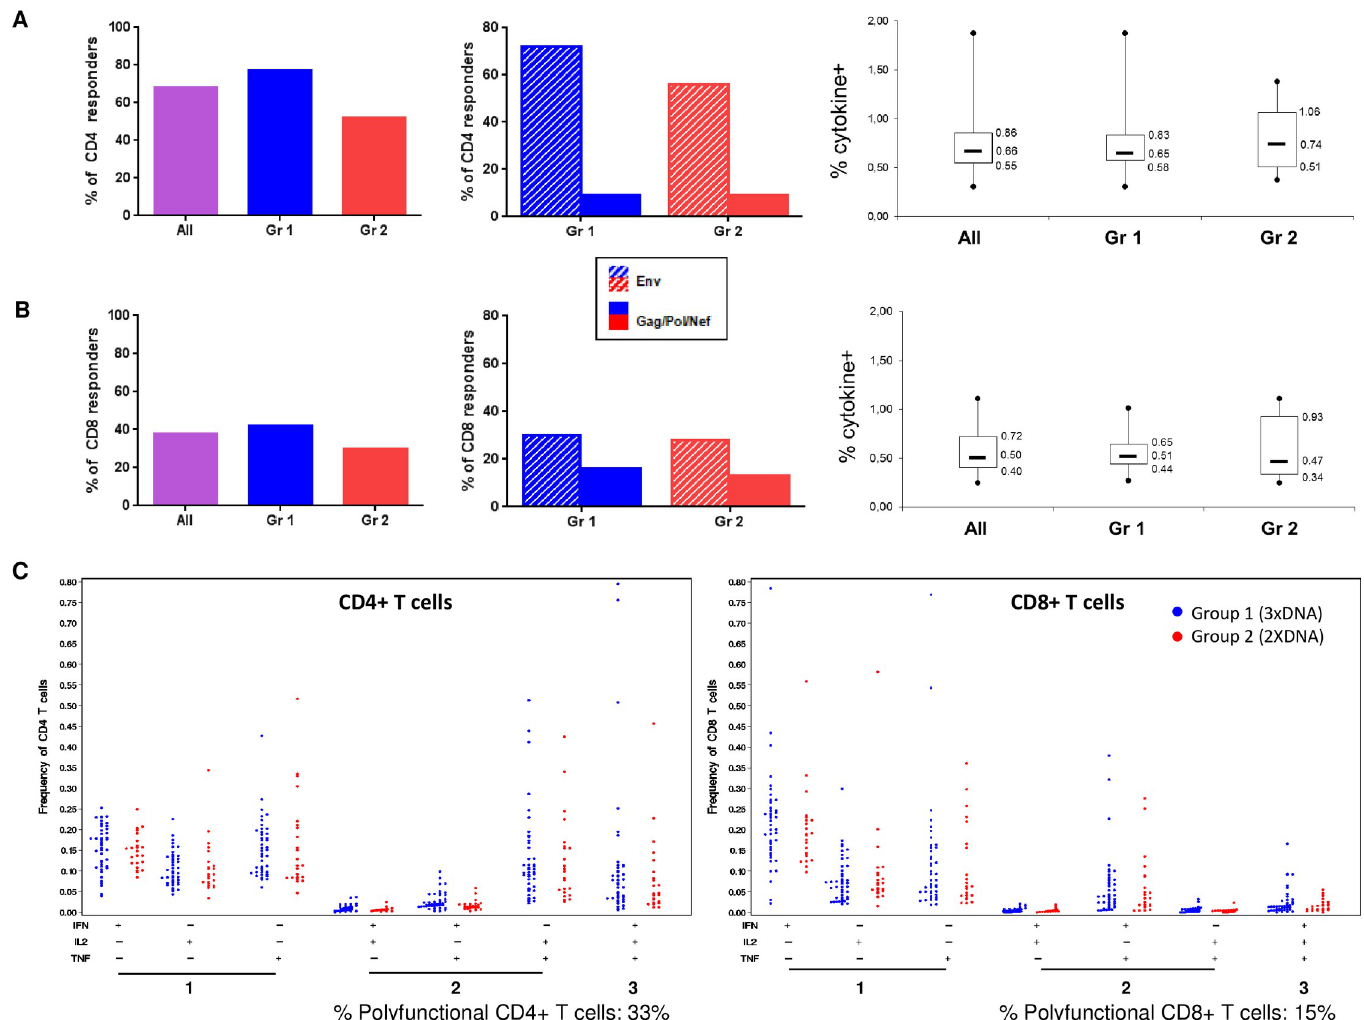
Fig 4. Frequency and magnitude of CD4 + and CD8 + T-cell responses in vaccine groups at the primary end points (weeks 26/28) measured by ICS assay, EV03/ANRS VAC20 Phase I/II Trial. A. Left panel: Frequency of positive response for CD4+ T cells producing at least one cytokine (IFN- γ , TNF- α or IL2) to at least one HIV pool in all participants (n = 72) or in each group (n = 43 in 3xDNA group, blue; n = 23 in 2xDNA group, red). Middle panel: Frequency of positive response for CD4+ T cells producing at least one cytokine to Env (hatched histograms) and Gag/Pol/Nef (solid histograms) in each group. Right panel: Magnitude of CD4+ T cell response in all participants and in each group. Boxes represent median values with IQR and whiskers represent min and max values. B. Left panel: Frequency of positive response for CD8+ T cells producing at least one cytokine (IFN- γ , TNF- α or IL2) to at least one HIV pool in all participants (n = 72) or in each group (n = 43 in 3xDNA group, blue; n = 23 in 2xDNA group, red). Middle panel: Frequency of positive response for CD8+ T cells producing at least one cytokine to Env (hatched histograms) and Gag/Pol/ Nef (solid histograms) in each group. Right panel: Magnitude of CD8+ T cell response in all participants and in each group. Boxes represent median values with IQR and whiskers represent min and max values. C. Polyfunctional profile of CD4+ (left panel) and CD8+ (right panel) T cell populations in each group (3xDNA in blue, 2xDNA in red). All the possible combinations of the responses are shown on the x axis, whereas the percentage of the functionally T cell populations are shown on the y axis.